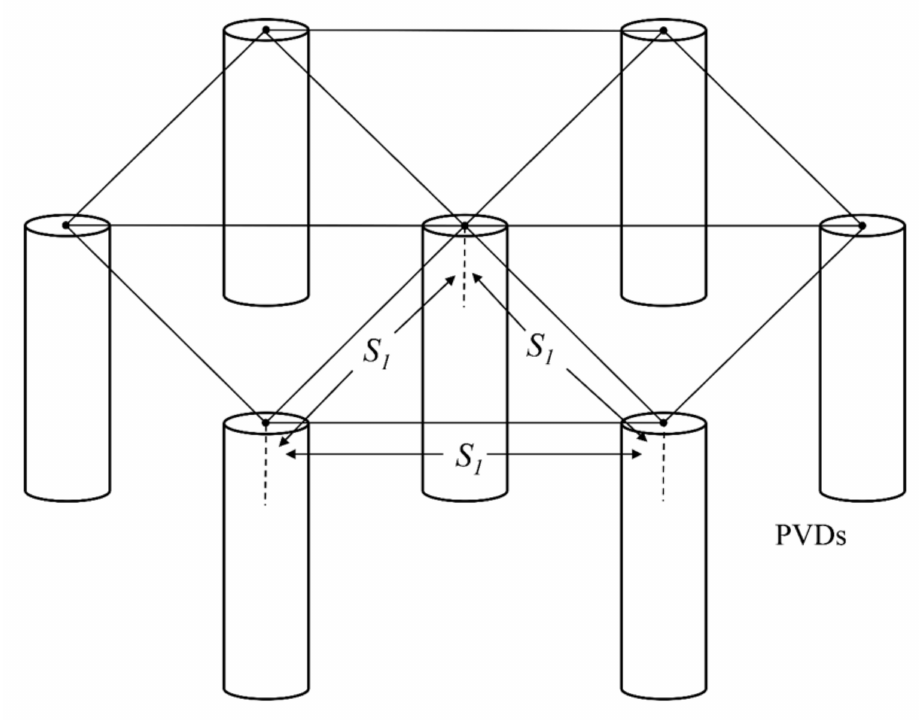
Figure 3. Layout of multiple